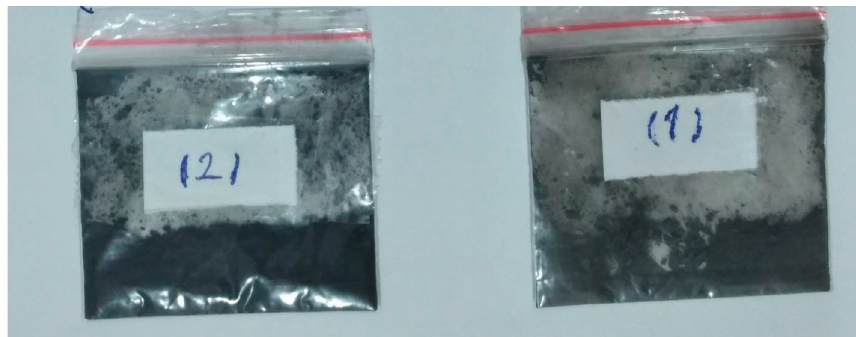
Figure 1: The synthesized CuO nanoparticles from Khalkhal [1] and Gilan [2]